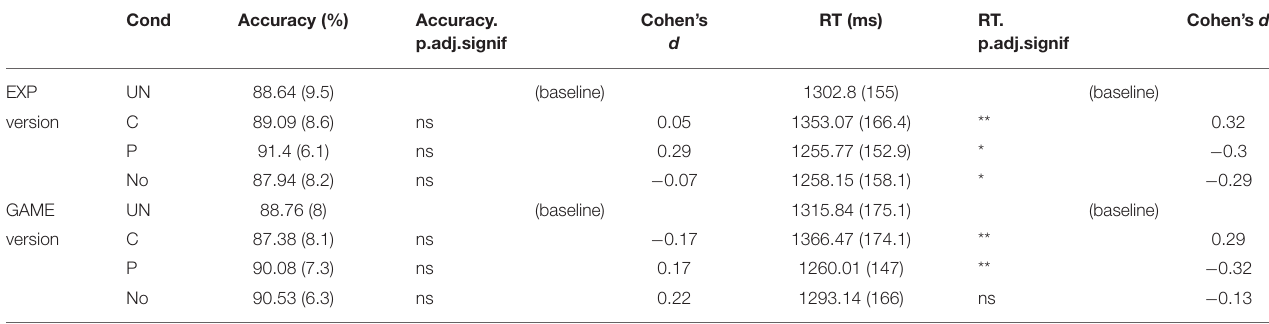
TABLE 3 | Experiment 3: Accuracy (%) and RT (ms) are shown as mean (s.d.).